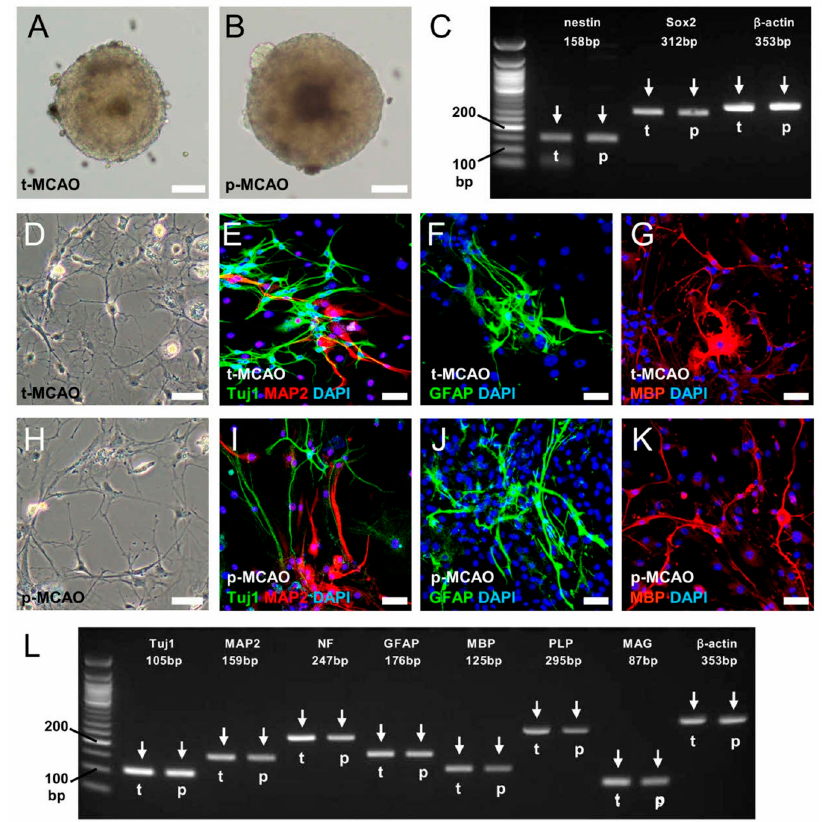
Figure 5. Following incubation of ischemic areas, neurosphere-like cell clusters were obtained from mice after 90-min t-MCAO ( A ) and p-MCAO ( B ). RT-PCR was used to analyze the cell clusters for NSPC markers (t-MCAO, t, arrows; p-MCAO, p, arrows), including nestin and Sox2 ( C ). After di ff erentiation, immunohistochemistry showed that these cells (90-min t-MCAO ( D ), p-MCAO ( H )) displayed the neuronal markers Tuj1 (90-min t-MCAO ( E : green), p-MCAO ( I : green)) and MAP2 (90-min t-MCAO ( E : red), p-MCAO ( I : red)), the astrocytic marker GFAP (90-min t-MCAO ( F : green), p-MCAO ( J : green)), and oligodendrocyte marker MBP (90-min t-MCAO ( G : red), p-MCAO ( K : red)). Nuclei were counterstained with DAPI ( E – G , I – K : blue). RT-PCR analysis revealed that the di ff erentiated cells displayed various neural markers, including for neurons (Tuj1, MAP2, NF), astrocytes (GFAP), and oligodendrocytes (MBP, PLP, MAG) ( L ). Results are representative of three replicates. Scale bars = 100 µ m ( A , B ) and 50 µ m ( D – K ). Abbreviations: DAPI, 4’,6-diamidino-2-phenylindole; GFAP, glial fibrillary acidic protein; MAG, myelin-associated glycoprotein; MAP2, microtubule-associated protein 2; MBP, myelin basic protein; NF, neurofilament; PLP, proteolipid protein; p-MCAO, permanent middle artery occlusion; t-MCAO, transient middle cerebral artery